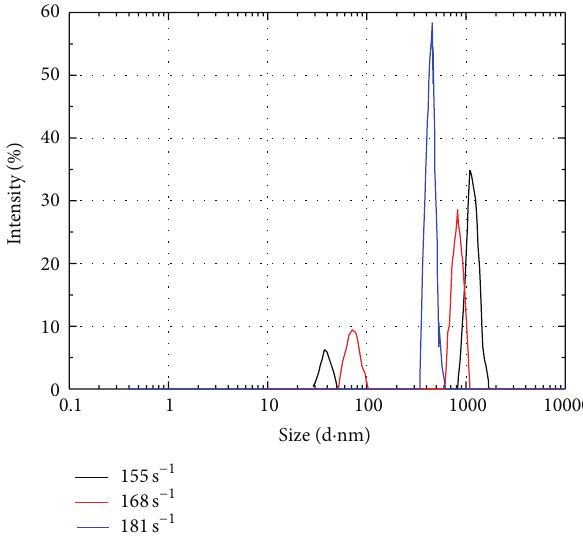
Figure 6: Particle size distribution curve of DPG at different shearing